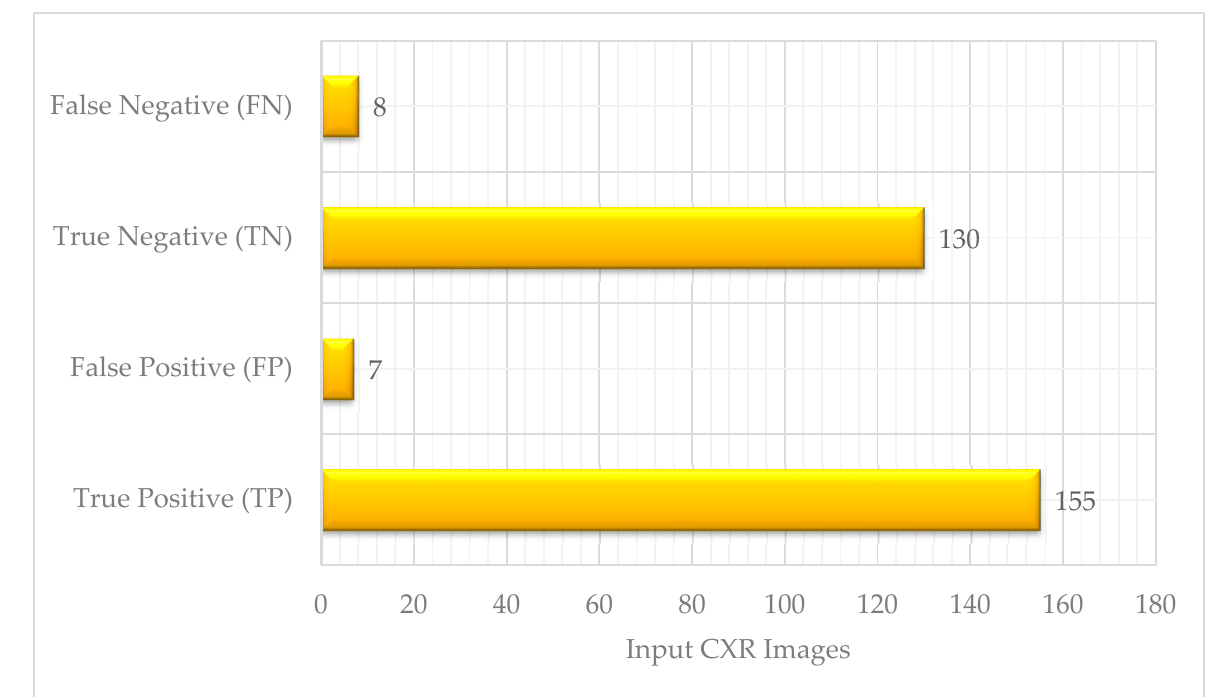
Figure 13. Evaluation metric characteristics for CXR input samples.